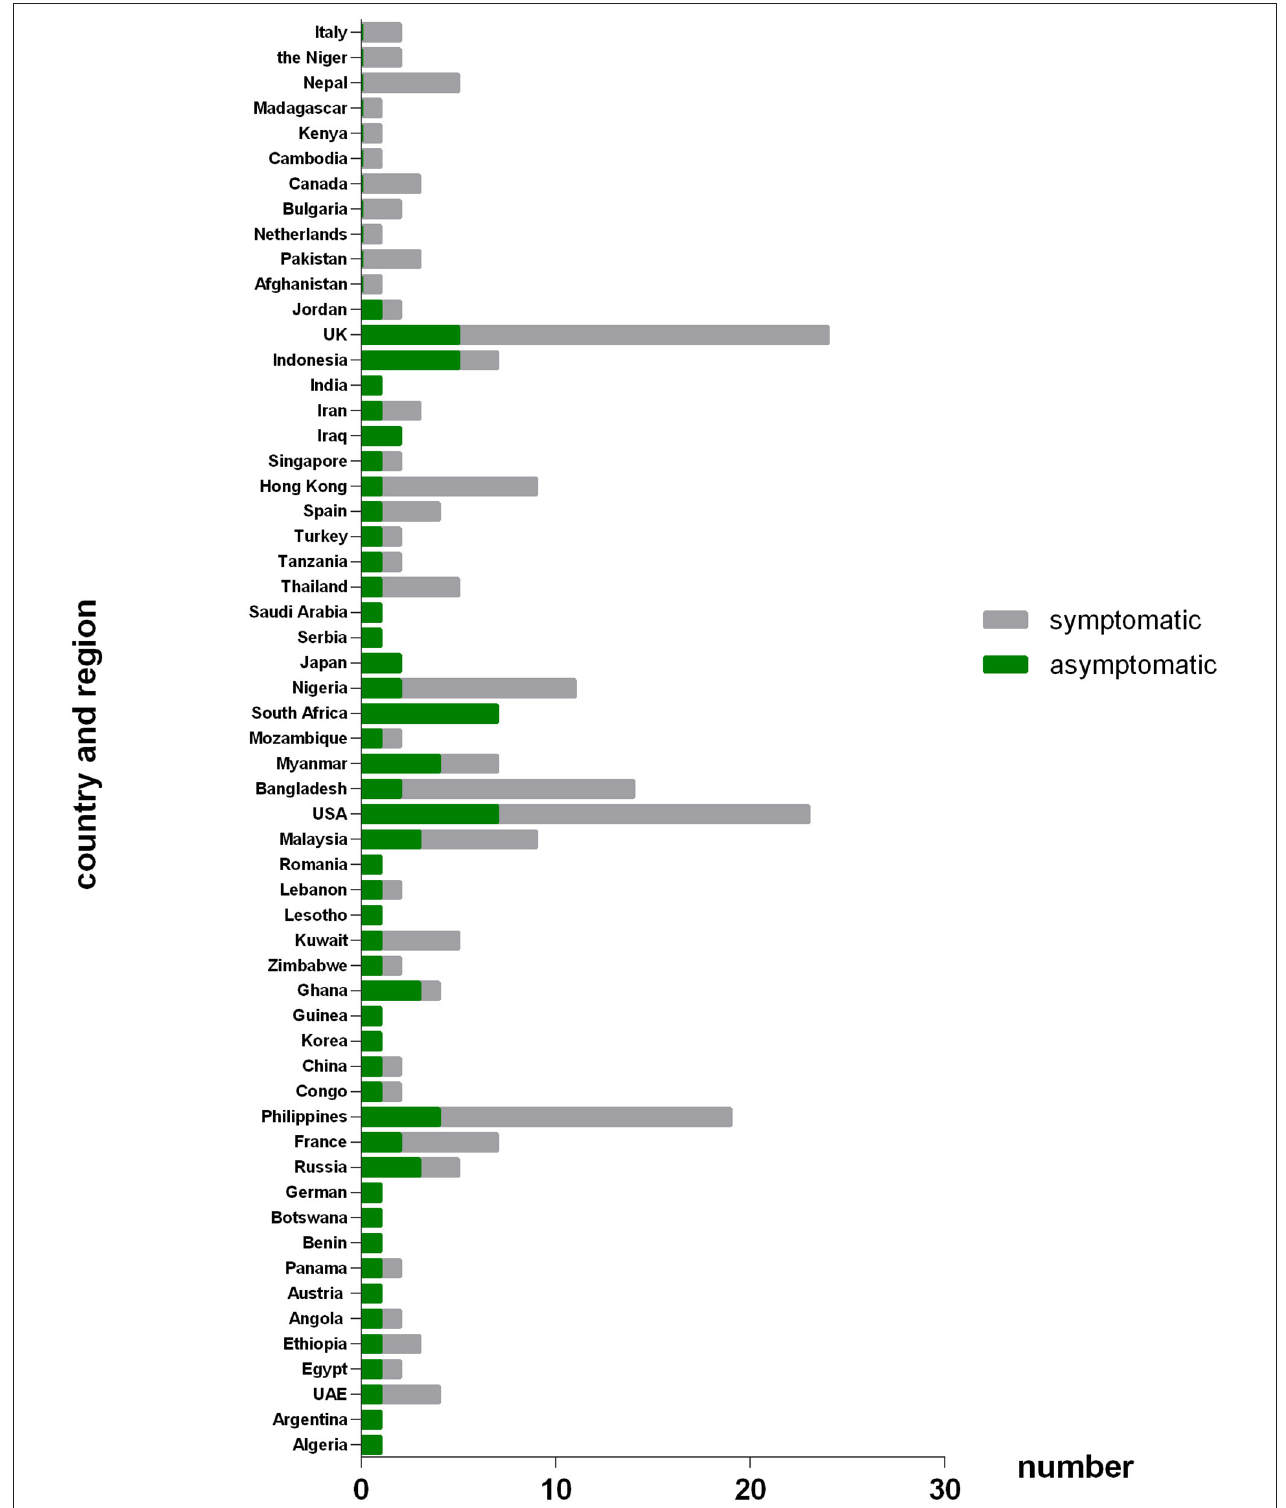
FIGURE 2 | Number of patients originated from different countries or regions between asymptomatic and symptomatic groups. The X axis refers to number of patients that come from different countries or regions; the Y axis refers to the different countries or regions that involved in this study. Patients originate from Russia, Ghana, Myanmar, Indonesia and especially South Africa was dominated by asymptomatic cases. While patients originate from France, Philippines, Kuwait, Malaysia, America, Bangladesh, Nigeria, and HK-China were dominated by symptomatic cases.